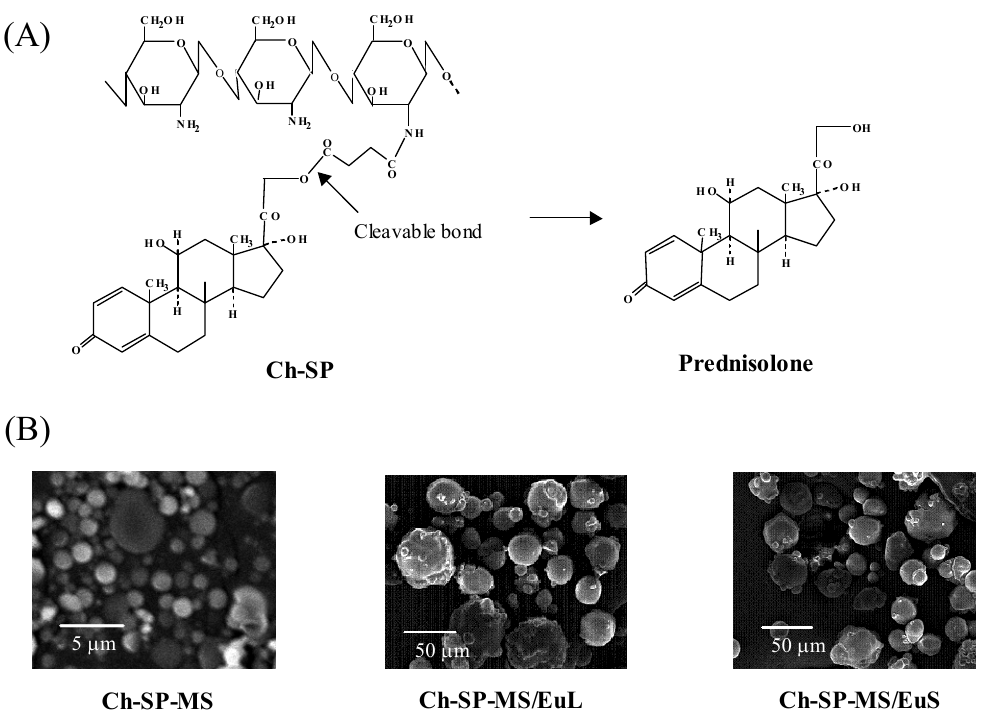
Figure 6. Chemical structure features of chitosan-succinyl-prednisolone conjugate (Ch- SP) (A) and scanning electron micrographs of their microspheres (Ch-SP-MS) and Eudragit L100 and S100-coated Ch-SP-MS (Ch-SP-MS/EuL and Ch-SP-MS/EuS, respectively) (B).